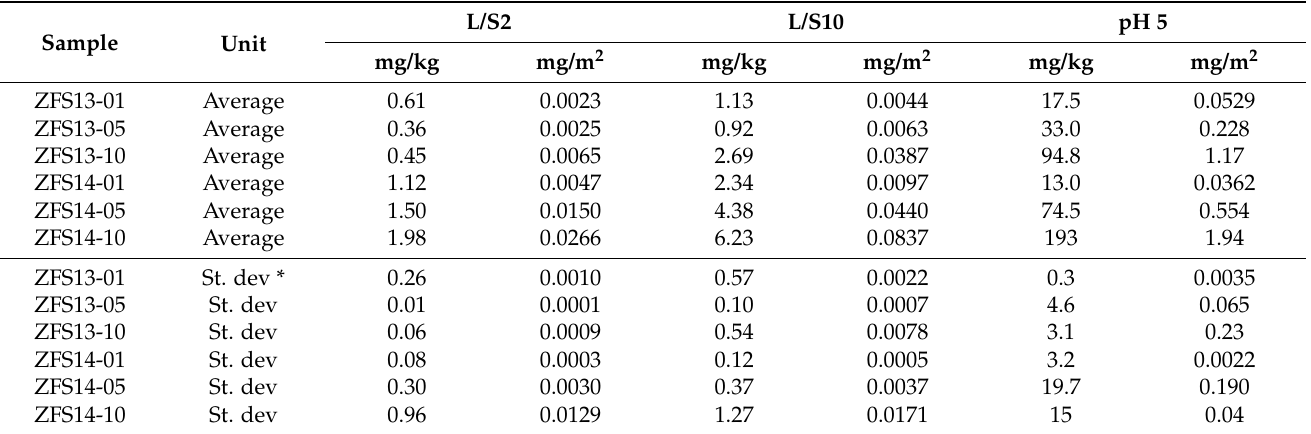
Table 4. Leaching data (mg/kg and mg/m 2 ) from leaching tests according to EN12457-3 and pH titration for the ZFS